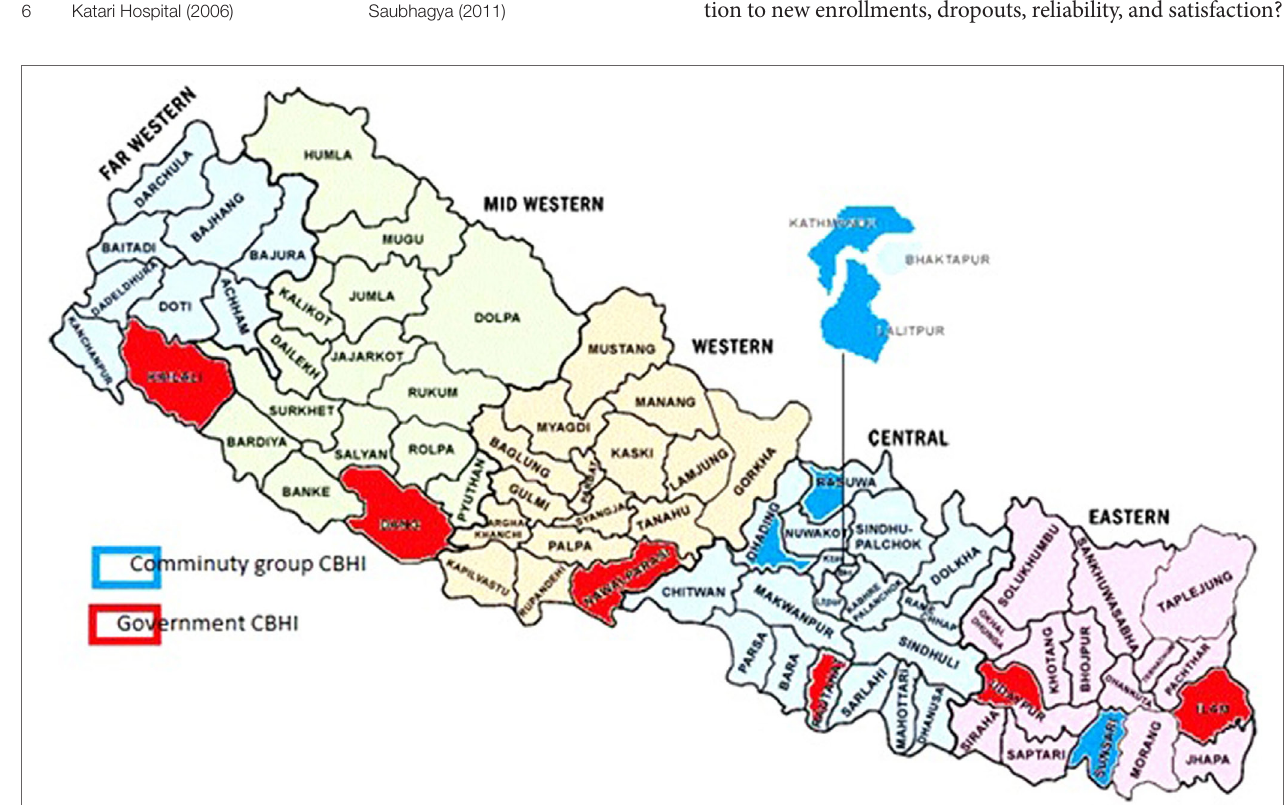
FigUre 2 | Geographical location of community-based health insurance.